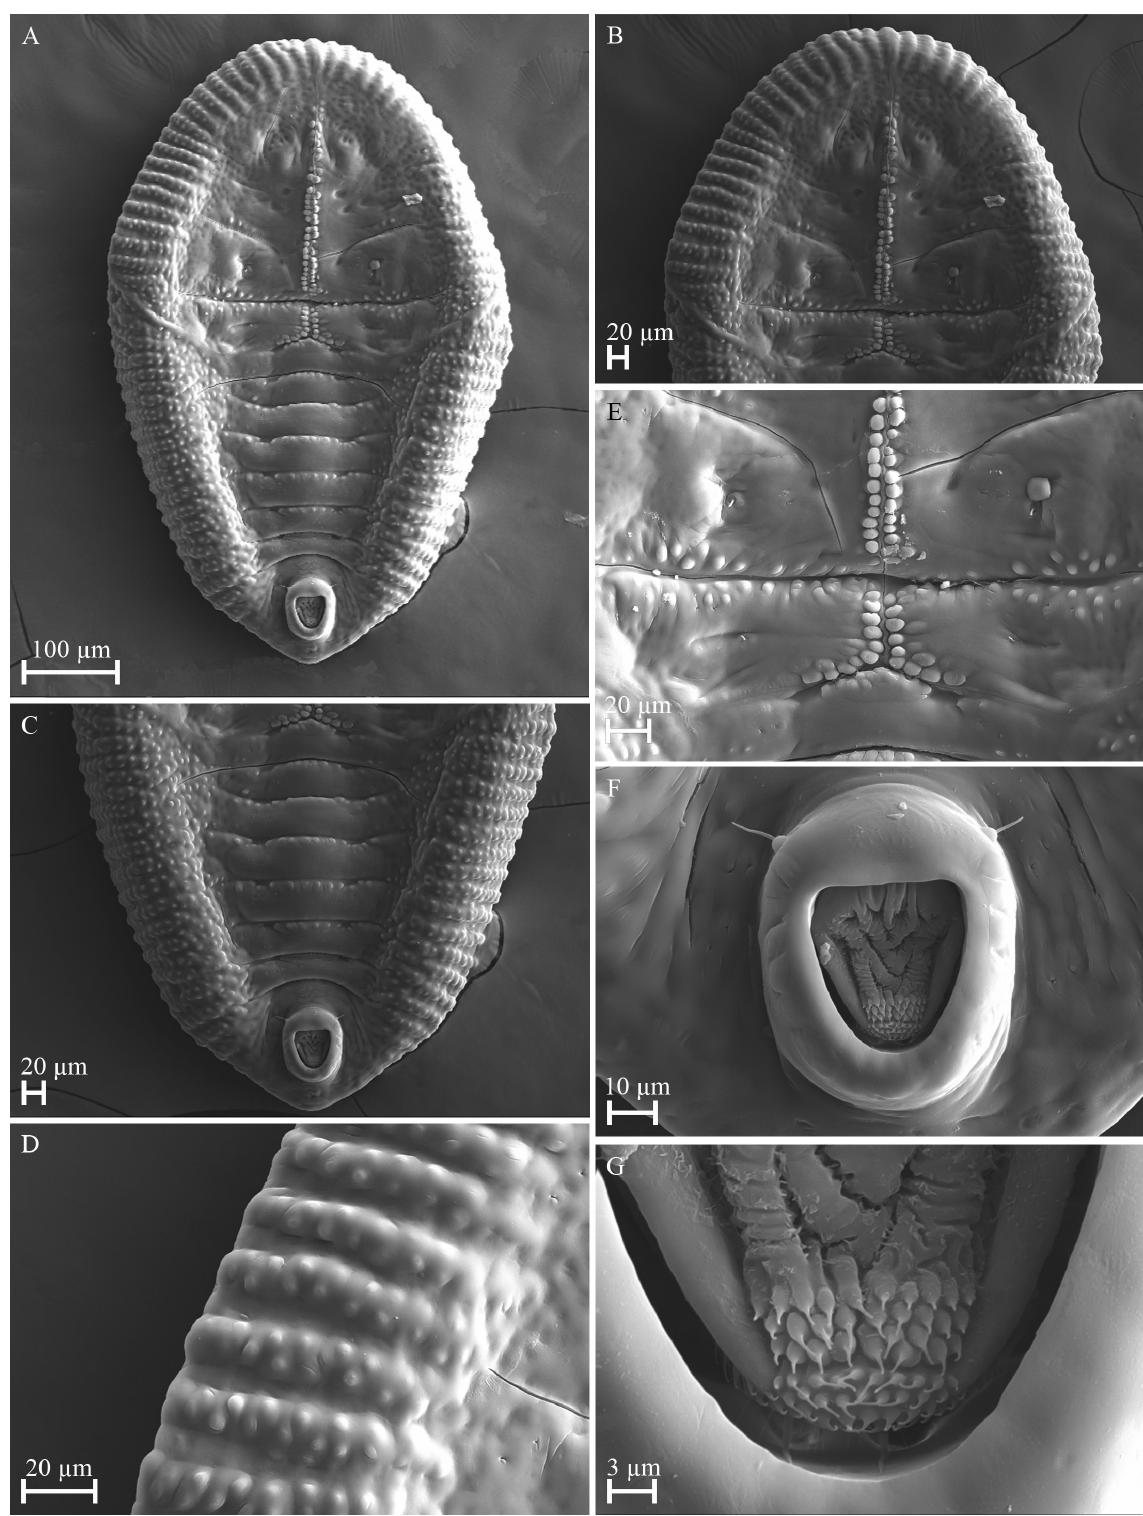
Fig. 8. Aleuropleurocelus ceanothi (Sampson, 1945), SEM microphotographs. A . Puparium, dorsal view. B . Cephalothorax. C . Abdominal area. D . Folded submargin. E . Meso- and metathorax, longitudinal suture. F . Vasiform orifice. G . Operculum apex, tuft of conical